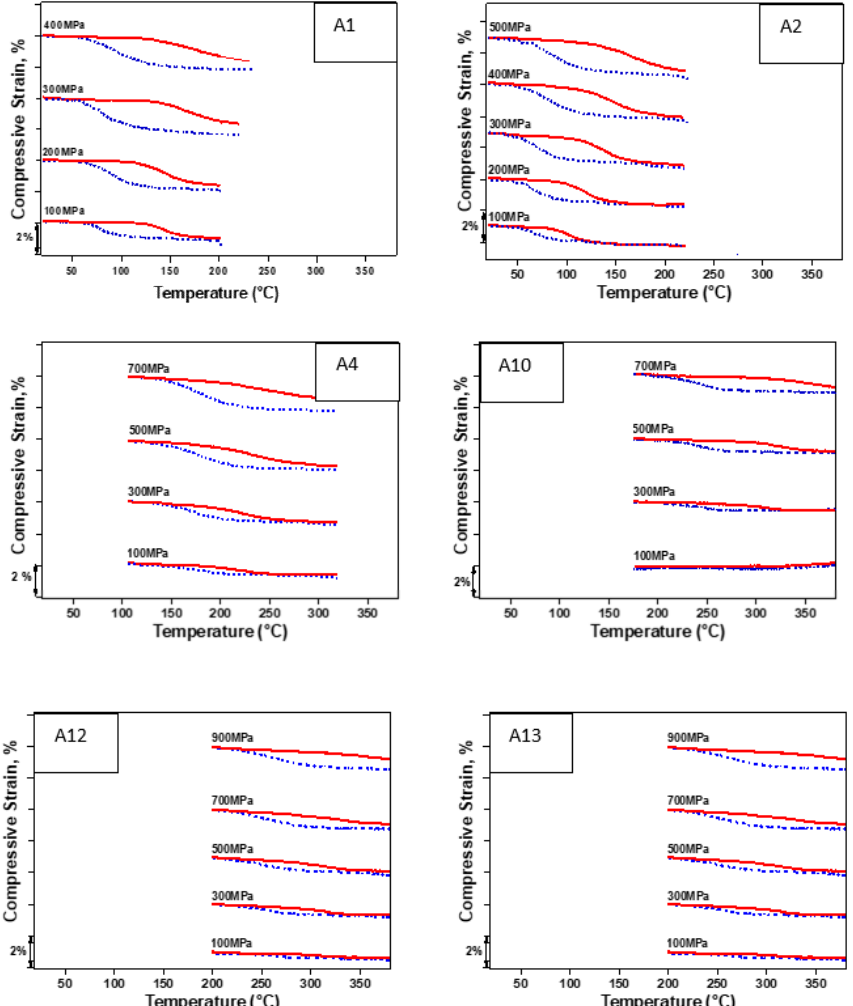
Figure 9. Constant force strain-temperature response of selected samples with energy densities below 100 J/mm 3 ( A1 , A2 , and A4 ) and above 100 J/mm 3 ( A10 , A12 , and A13 ) under different constant stress levels. Values of constant stresses are shown on each curve. Heating curves are shown in solid red; cooling curves are shown in blue dashed lines.